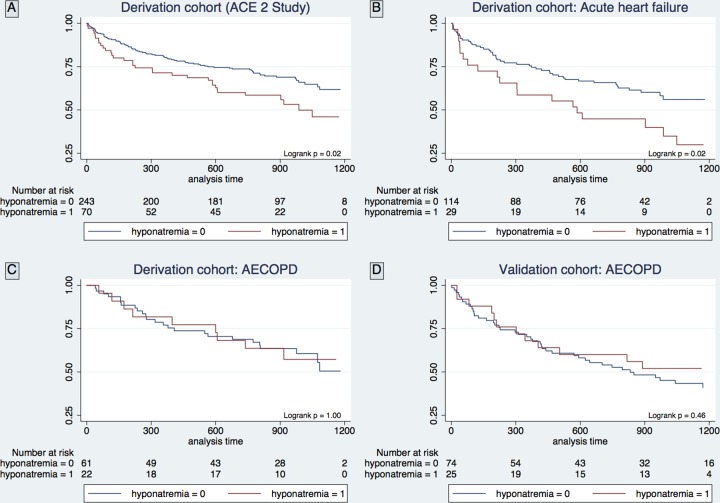
Kaplan-Meier survival plots stratified according to the presence of hyponatremia